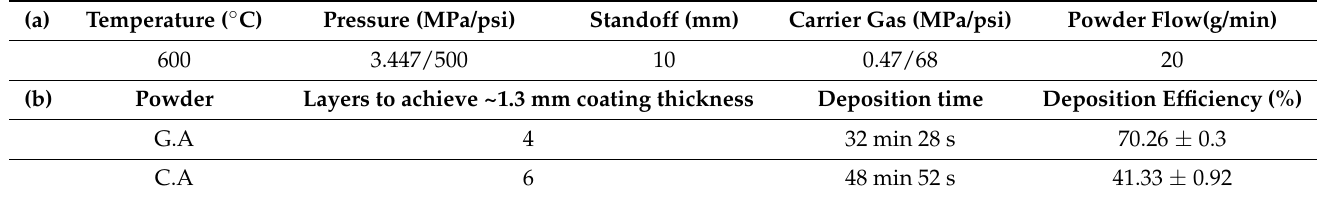
Table 2. Deposition parameters and experimental